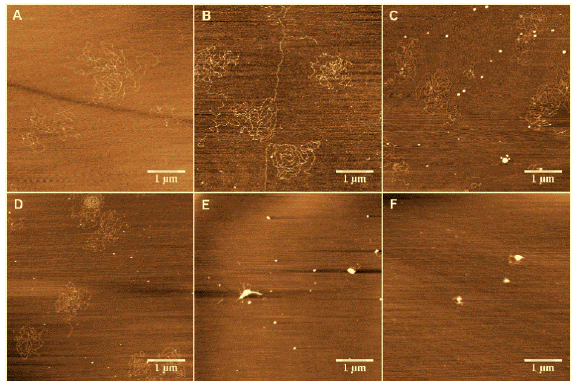
Figure 2. AFM observation of DNA complexes. Panel ( A ) λ -DNA in 5 mM Mg 2+ solution; Panels ( B – F ) DNA conformations at different concentrations (0.01, 0.05, 0.1, 0.5 and 1 mM, respectively) of As + in 5 mM Mg 2+ buffer.